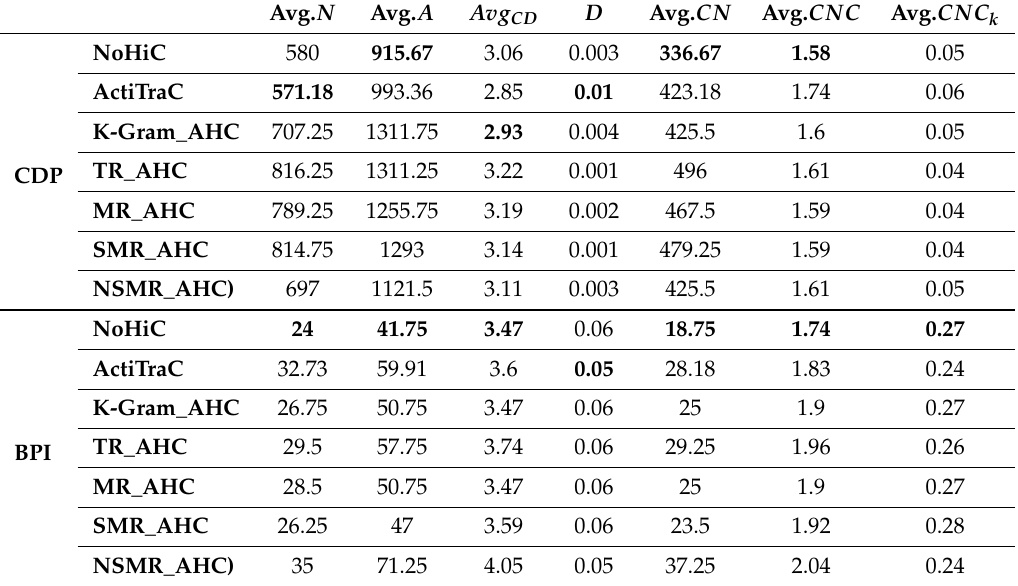
Table 10. Comparison of the complexity metrics for discovered clusters through NoHiC, ActiTraC and AHC trace clustering